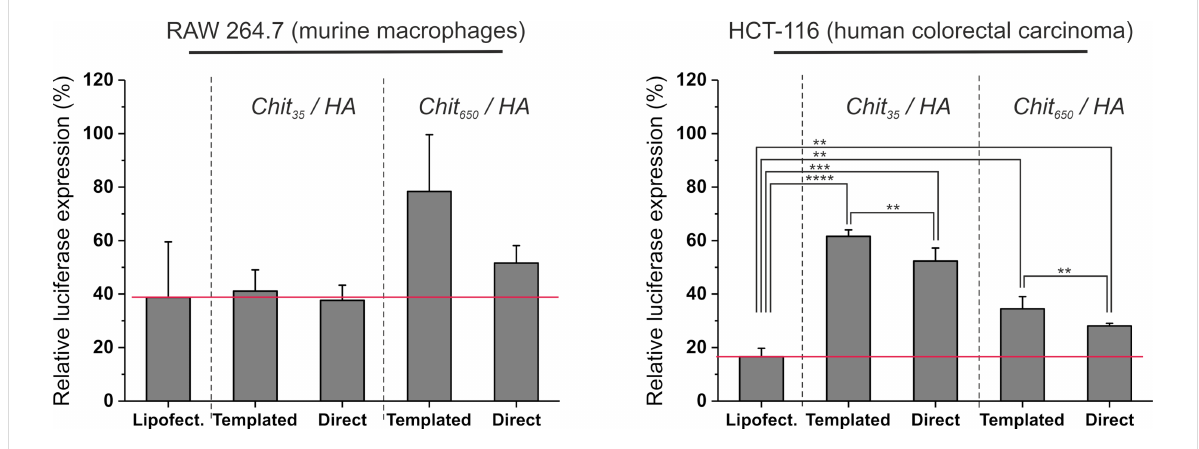
Figure 6: siRNA-mediated luciferase silencing using nanoparticles obtained via a templated or direct complexation method. The results are expressed as the percentage of luciferase expression relative to the average RLUs of the negative control (i.e., cells pre-transfected with the pGL3 plasmid DNA, without anti-Luc siRNA treatment) ( n = 3). Statistical analysis (T-test, two-tailed) showed no significant differences between preparative methods in RAW macrophages, but a somehow better silencing efficiency of direct complexation (and of high- M W chitosan) in